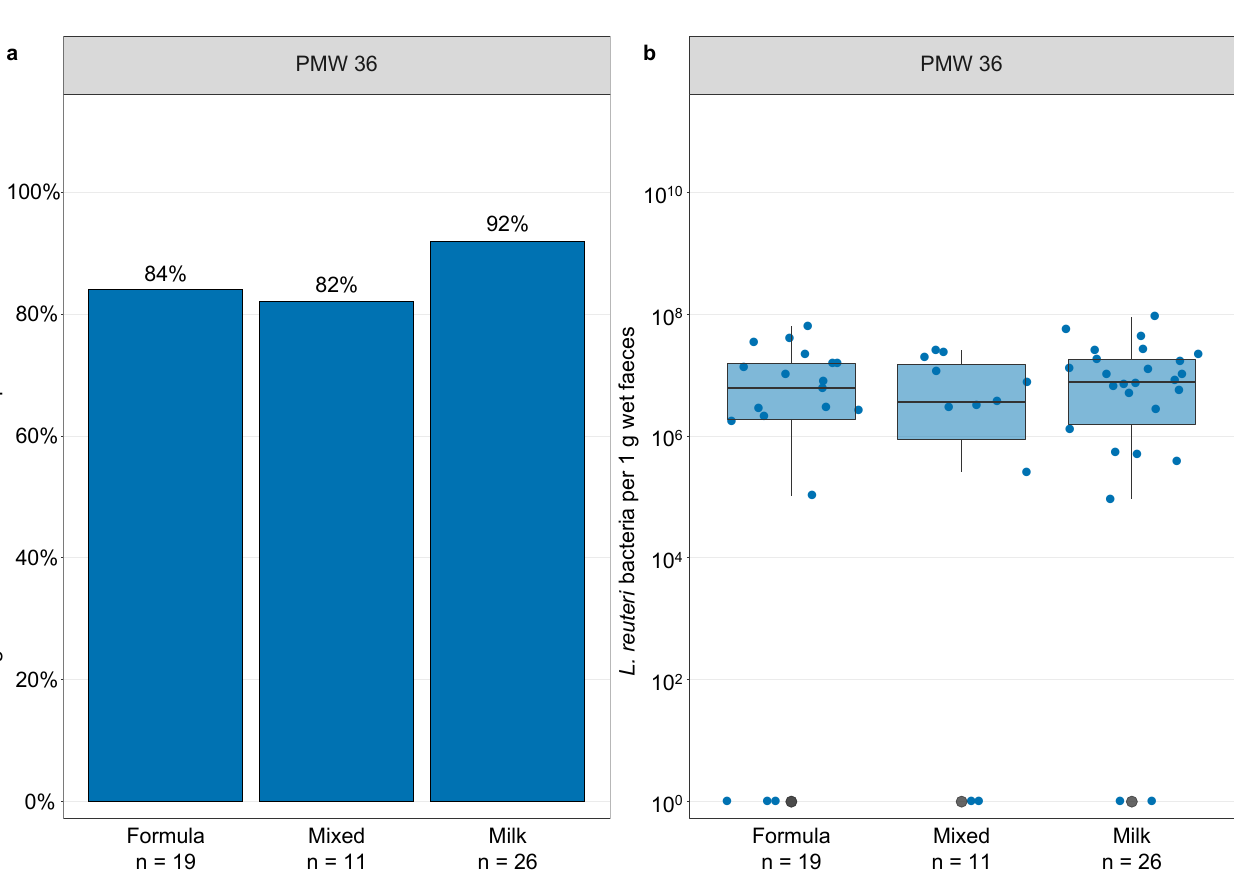
Figure 5. Infant feeding and L. reuteri colonisation in the L. reuteri -supplemented group. L. reuteri prevalence ( a ) and abundance ( b ) in faeces of L. reuteri -supplemented extremely preterm ELBW infants by feeding type. Prevalence is expressed as the percentage of infants with a L. reuteri -positive faecal sample and the total number of infants in each feeding category. Abundance is shown as the number of L. reuteri bacteria per 1 g wet faeces. Boxplots show median with 25% and 75% percentiles and 1.5 × the interquartile range. For graphical display, the number of L. reuteri bacteria per 1 g wet faeces in ( b ) was set to 10 0 for infants with L. reuteri -negative faeces. Infants in the partially breast milk-fed (‘mixed’) feeding group received 1–50% breast milk. Statistics: Fisher’s exact test ( a ), Kruskal–Wallis test ( b ). ELBW = extremely low birth weight, PMW = postmenstrual